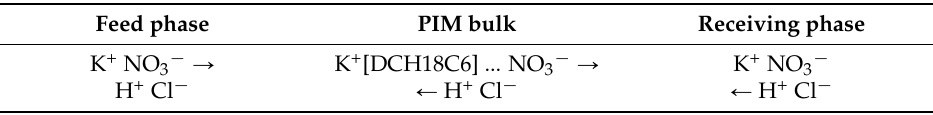
Table 5. Co-transport mechanism of KNO 3 in PIM containing